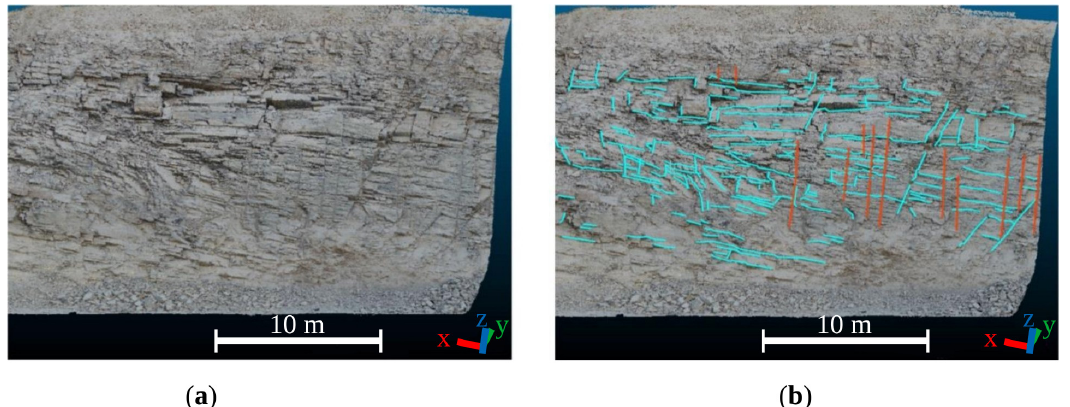
Figure 14. ( a ) A 32 m section of a bench with a highly fractured rock mass in Mine C. ( b ) Mapping fractures (cyan) and half-cast pre-split holes (orange).